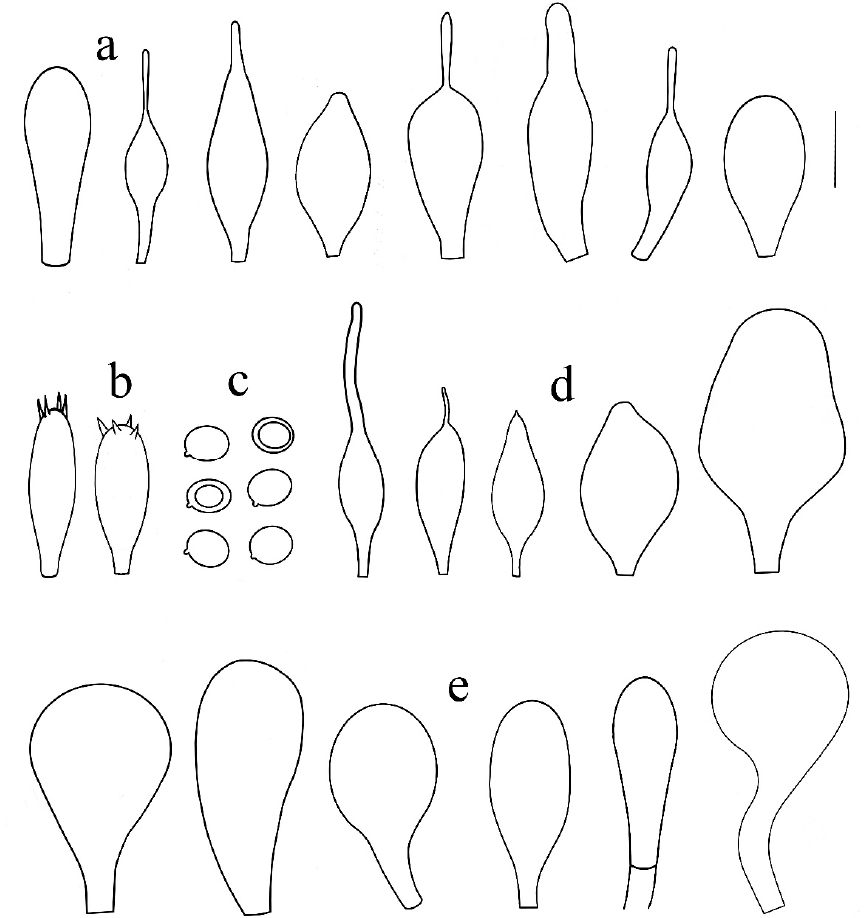
Figure 5. Pluteus pseudoinsidiosus holotype LIP0401350: ( a ) cheilocystidia; ( b ) basidia; ( c ) spores; ( d ) pleurocystidia; ( e ) pileipellis elements. Scale bar 20